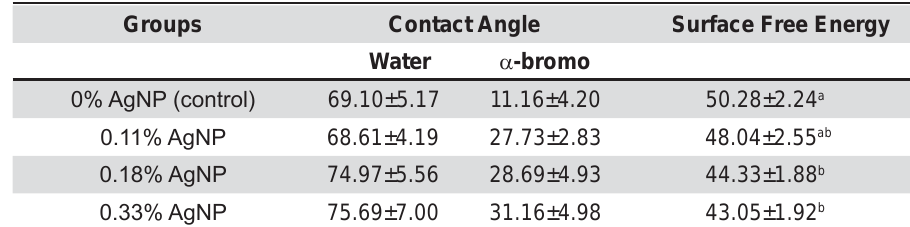
Table 2- Mean and standard deviation of contact angle (CA) and surface free energy (SFE) from different concentrations of